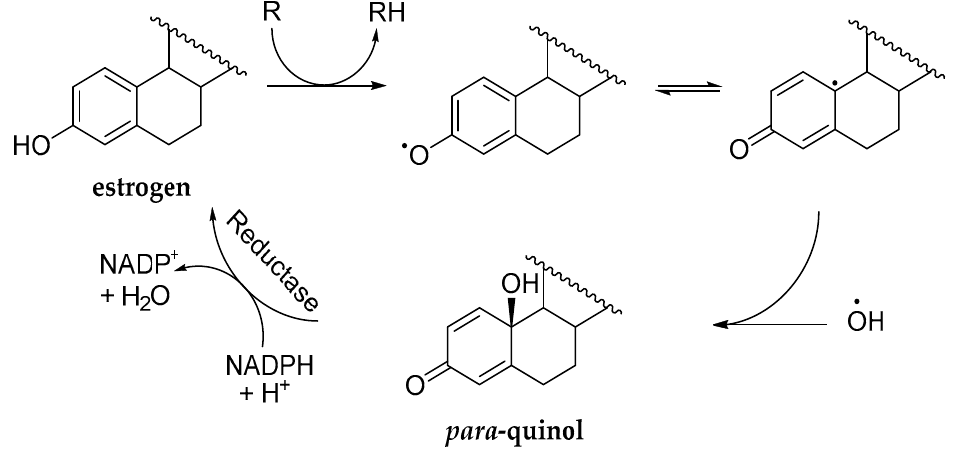
Figure 2. A novel antioxidant cycle for estrogens through the formation of para -quinol upon, e.g., chain-breaking H-atom transfer to a free radical (R • ), leading to estrogen-derived phenoxyl radical that scavenges • OH. The para -quinol is then reduced back to the parent hormone by an enzyme-catalyzed process involving the reduced form of nicotinamide adenine dinucleotide phosphate (NADPH) as a cofactor to rejuvenate the antioxidant estrogen.